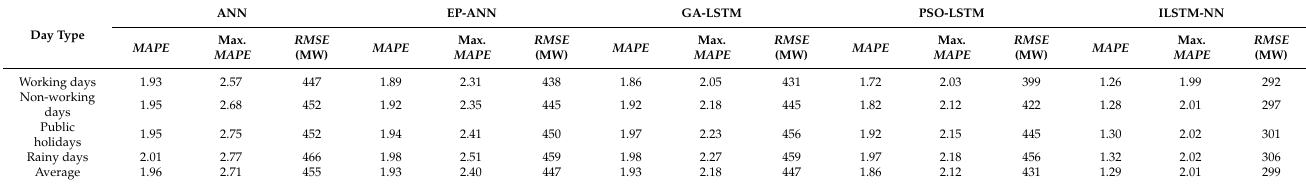
Table 1. A comparison of the load forecasting error values ( MAPE , Max. MAPE , and RMSE )